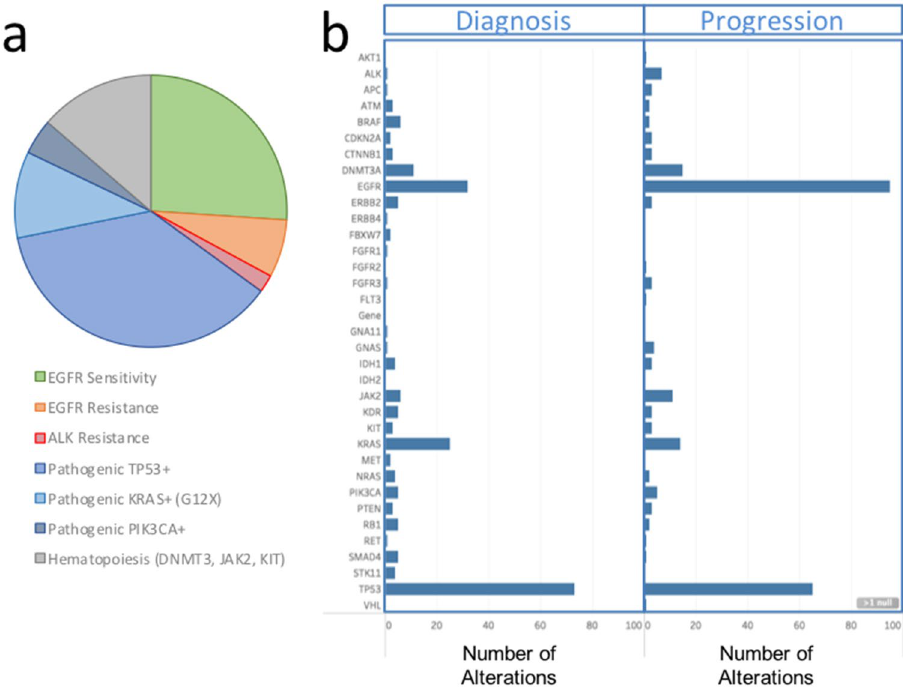
Figure 4. ( a ) The prevalence of clinically-significant mutations over the entire population is presented as a pie chart by type. ( b ) A histogram of gene-level mutational load, with numbers of observations (x-axis) versus gene (y-axis labels). Changes in prevalence between the initial diagnosis cohort (left) and progression cohort (right) are readily observed for the EGFR gene.